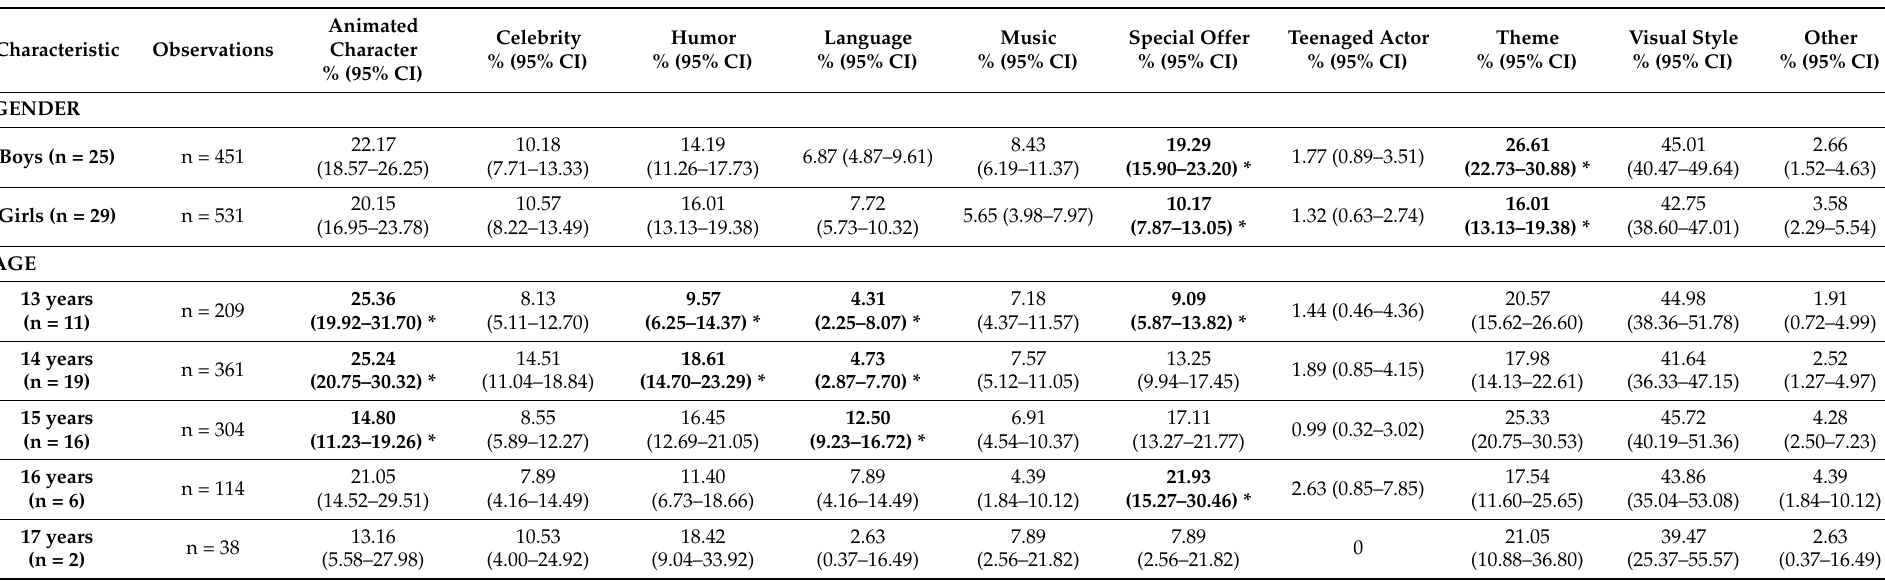
Table 5. Frequency of teen-targeted indicators identified by gender and age (statistical differences determined by exclusivity of the 95% confidence intervals are bolded and denoted by